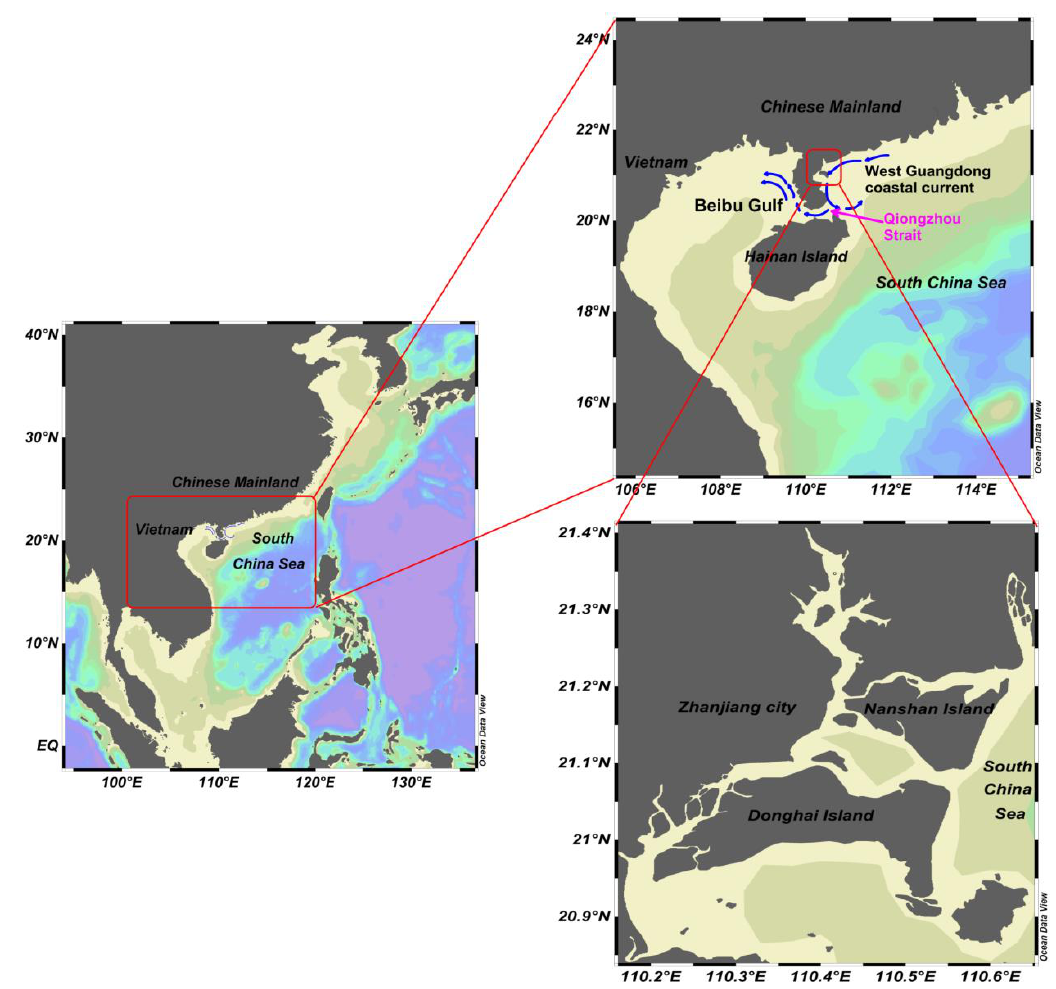
Figure 1. The location of Zhanjiang Bay (ZJB).